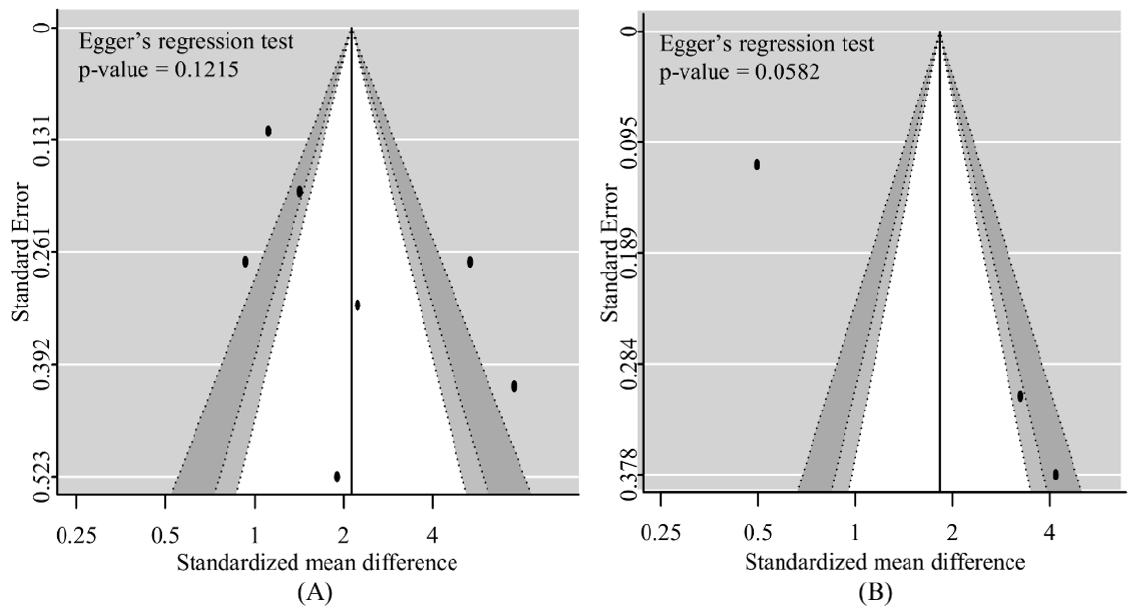
Figure 5. Funnel plot assessing publication bias for a poor neurological outcome and death. ( A ): Publication bias for a poor neurological outcome; ( B ): Publication bias for death.